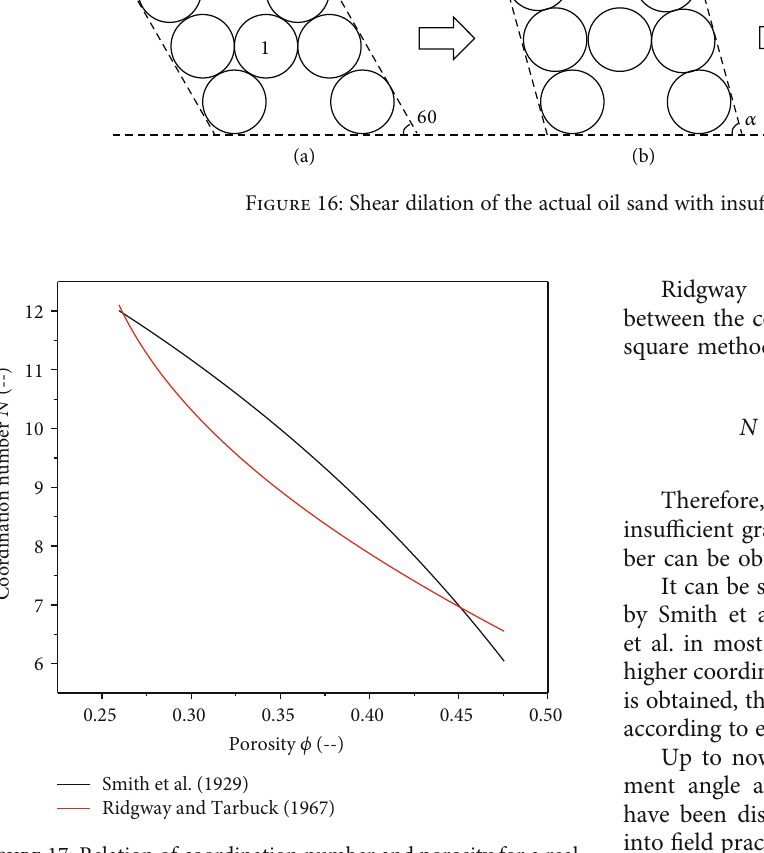
Figure 17: Relation of coordination number and porosity for a real oil